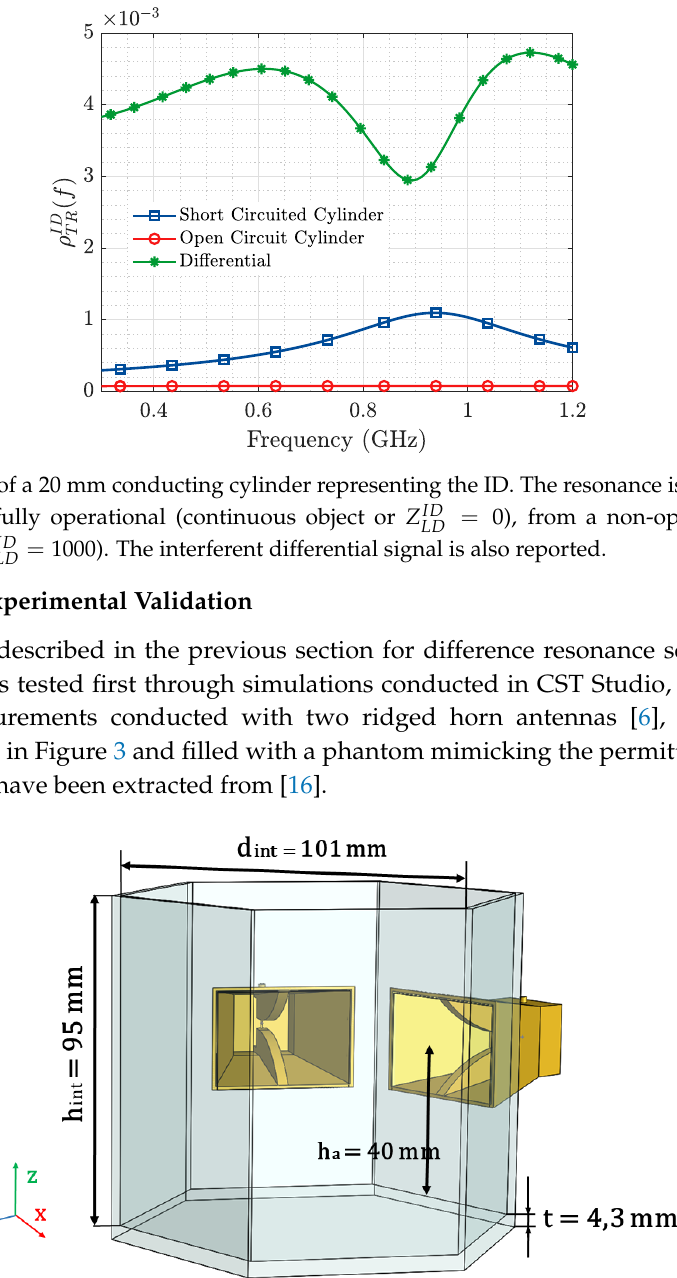
Figure 3. Schematic of the Experimental Measurement Set